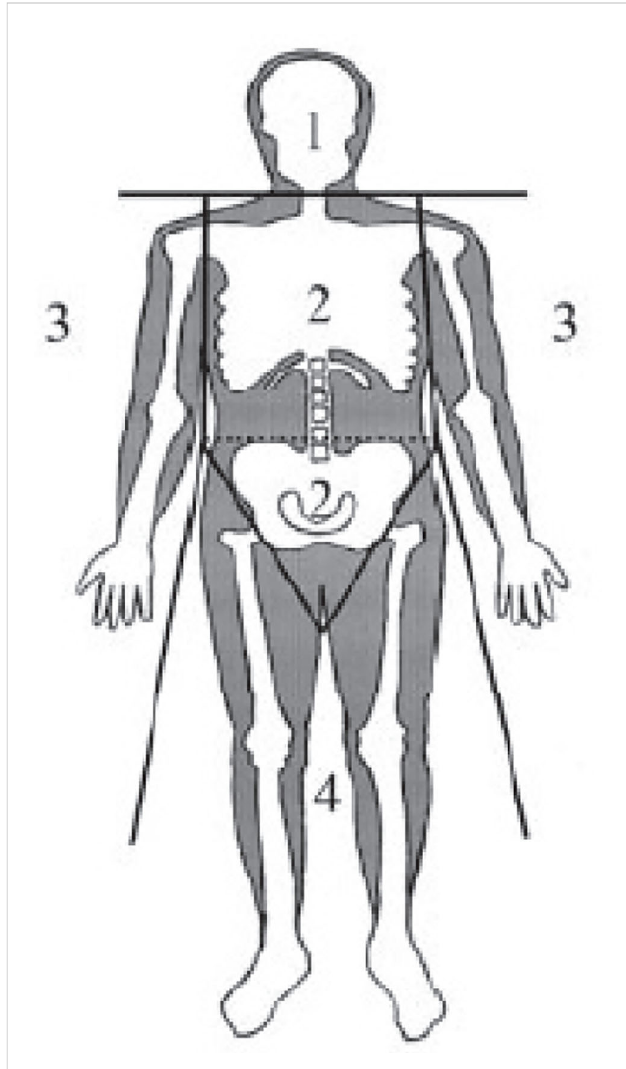
FIGURE 1 Standard regions of a dual-energy X-ray absorptiometry scan: 1, head; 2, trunk; 3, arms; 4, lower